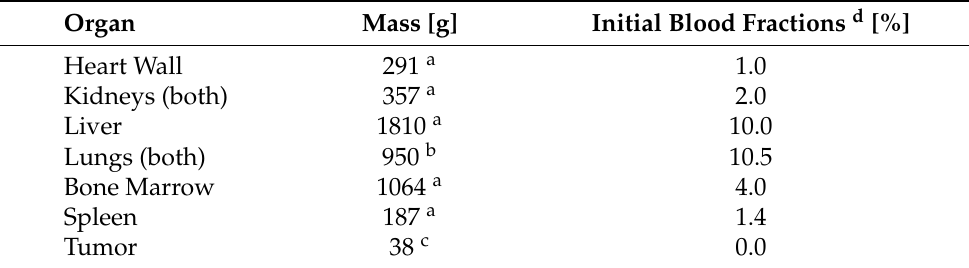
Table 1. Summary of the organ masses employed for scaling the activities per mass reported in [7] into total relative activities, and relative blood content of each organ: a Taken from Table A.2 of the ICRP-133 [31] (tissue with blood); b Taken from Table 2.8 of [30] (tissue plus blood contribution); c Mass reported by [7]; d Taken from Table 7.7.2 of